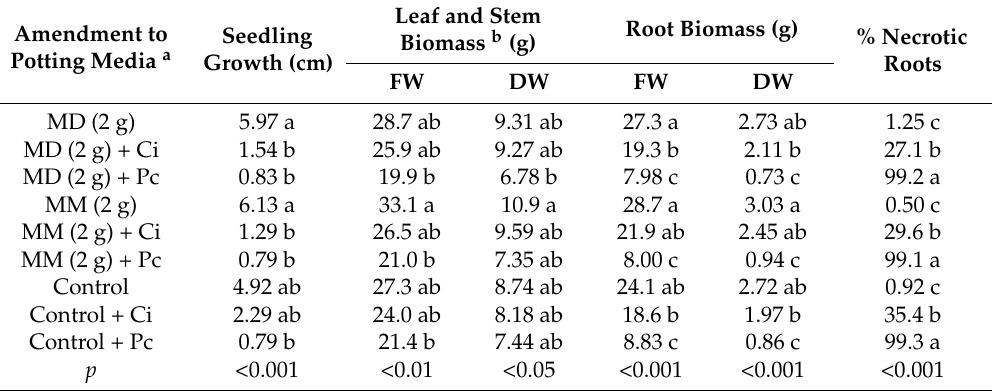
Table 10. Plant growth and severity of root rot after amendment of potting mix with either Mineral Dust (MD) or Mineral Mulch (MM) and subsequent inoculation with Ci and Pc, Experiment 3. Leaf and Stem Amendment to Seedling Potting Media a Growth (cm)